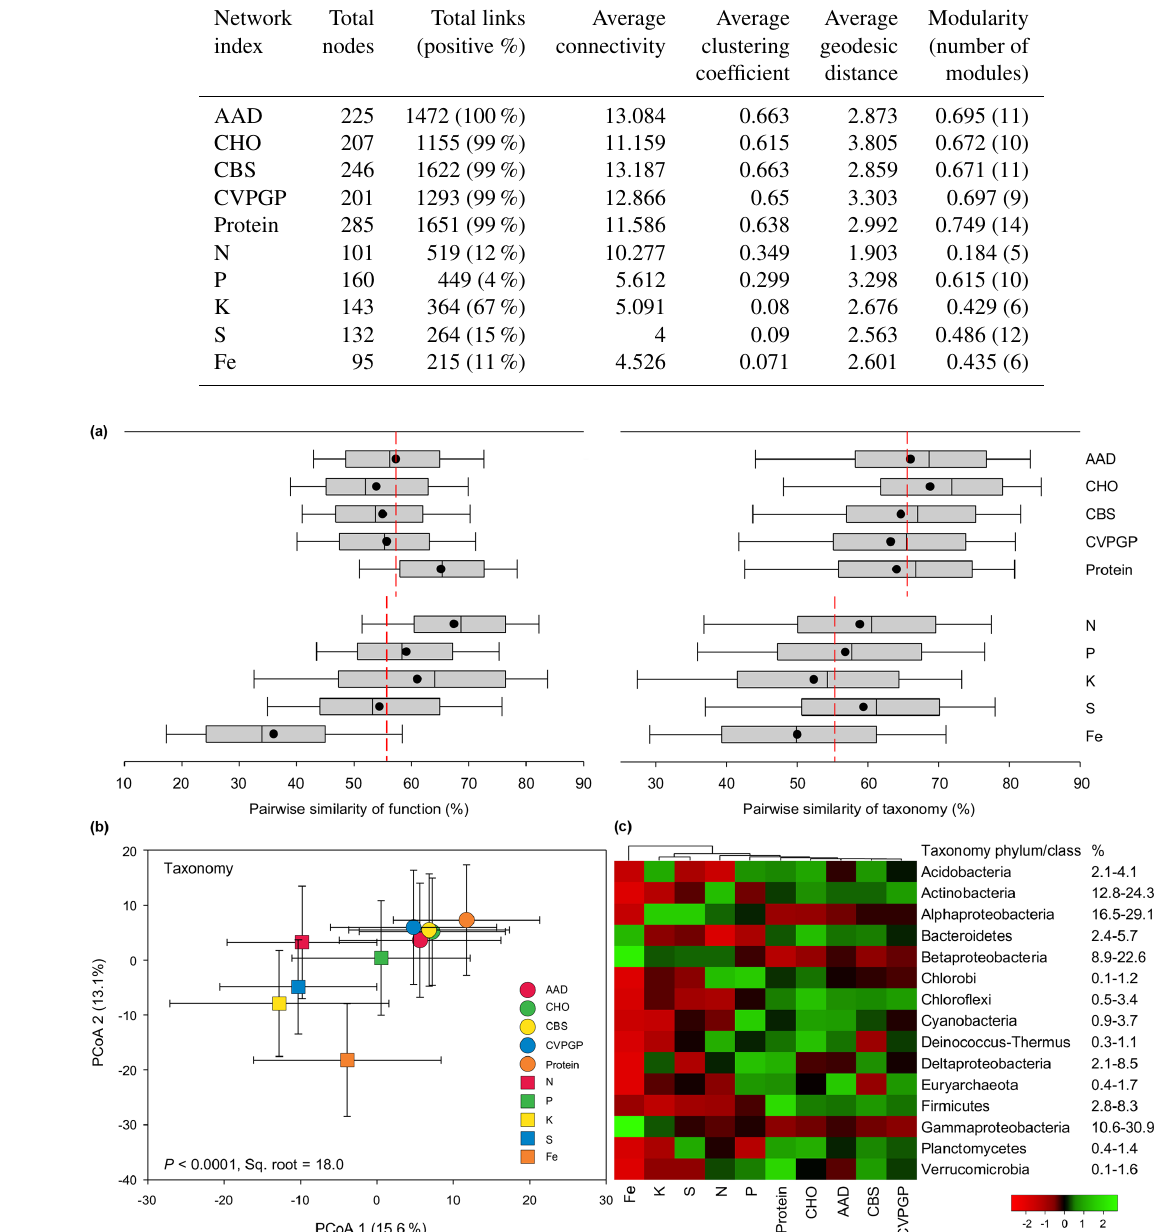
Table 1. Summary of key properties of co-occurrence networks for the five broad and the five narrow functions.